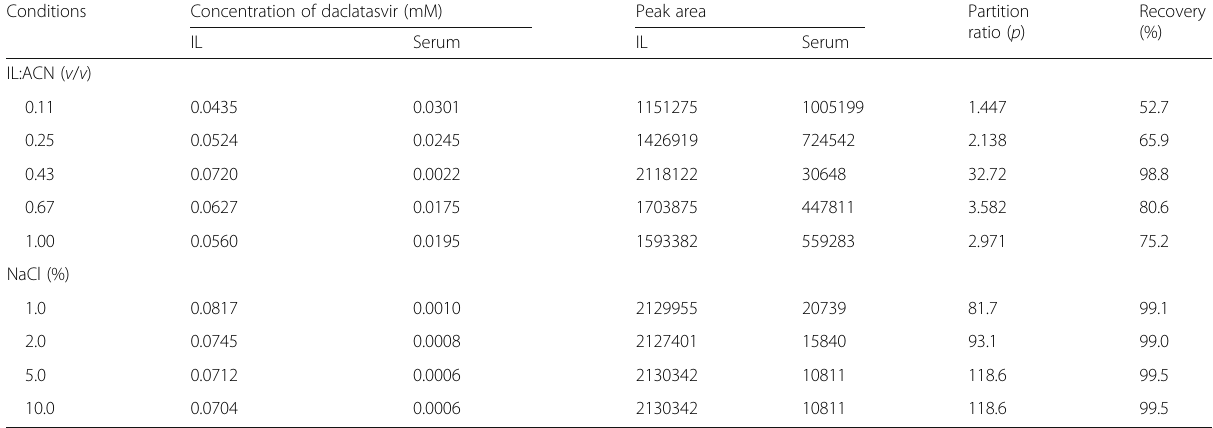
Table 2 Partition ratio and recovery (%) of daclatasvir a at different IL:ACN ratios and NaCl concentrations